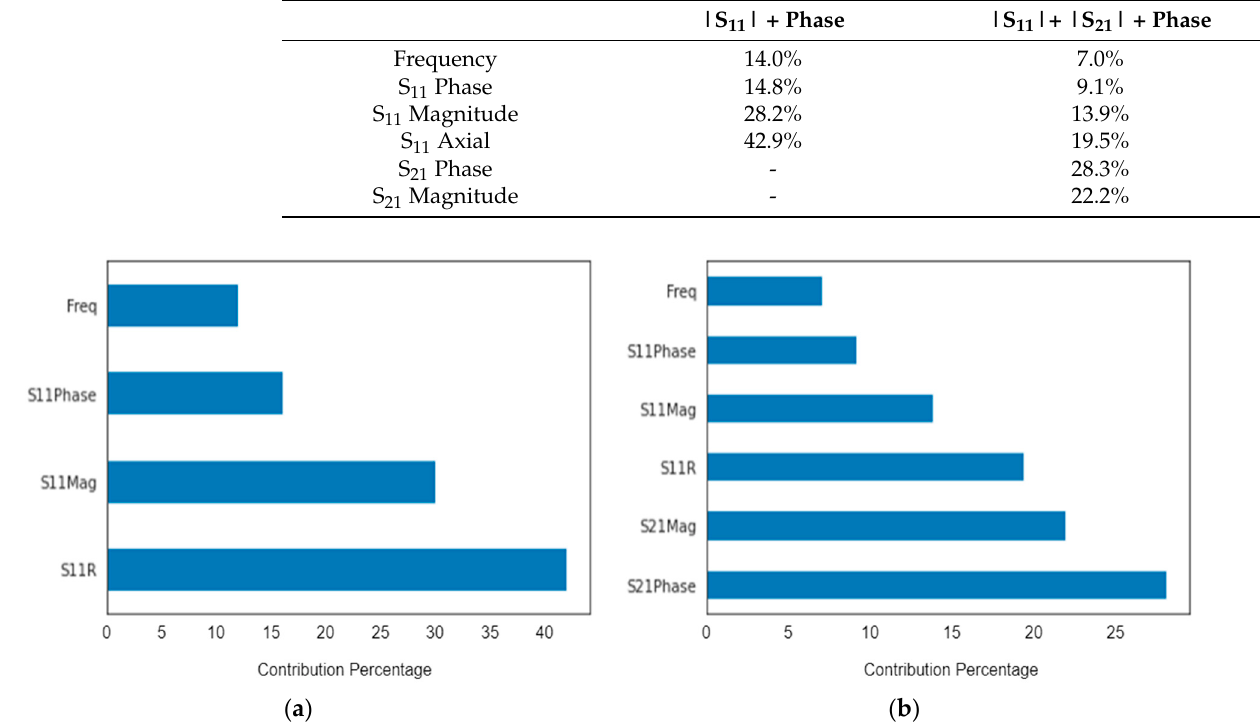
Table 5. Feature importance of each parameter in the two datasets for the “CatBoost” algorithm.